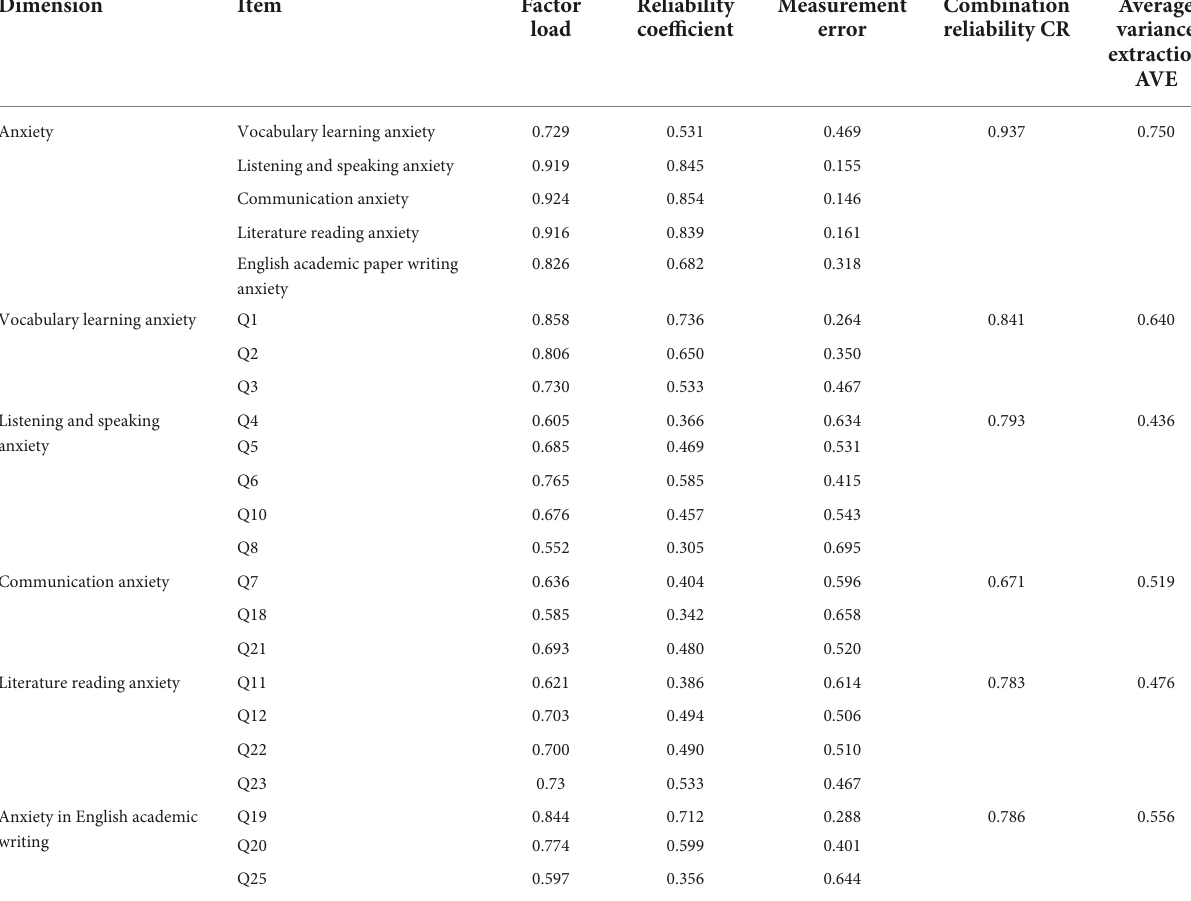
TABLE 3 Scale convergence validity